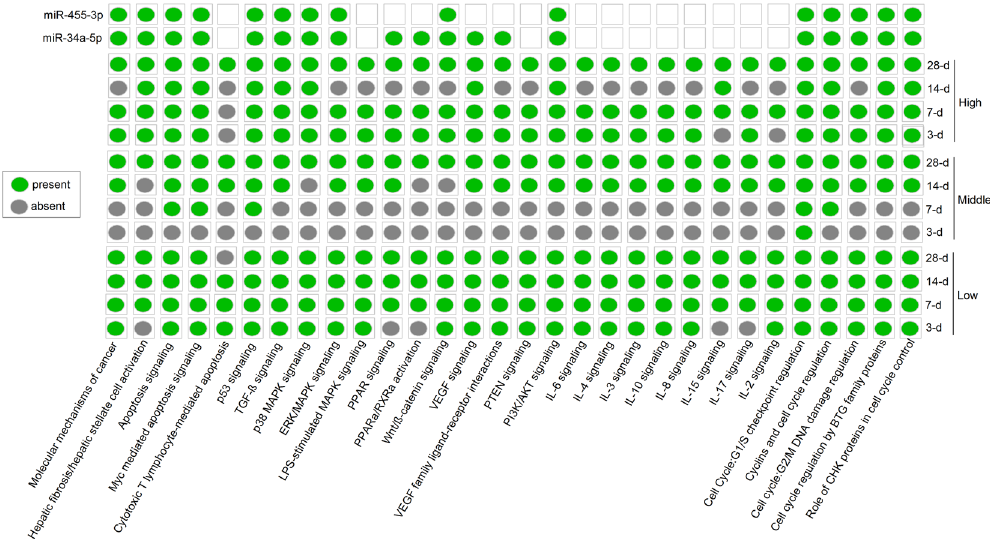
Figure 3. Heat map of most relevant pathways on DEMs. This heat map depicts the most significant and highly relevant pathways obtained using experimentally verified targets of differentially regulated miRNAs (DEMs). Information on different doses and time intervals is shown on the right side and relevant signaling are shown at the bottom. Information on two potential early and sensitive miRNA biomarkers (miR-34a-5p and miR-455-3p) and their associated signaling is given on the top two rows. The top two rows depict whether a given miRNA is predicted to regulate a selected pathway or not. The “green” and “gray” colors indicate either a pathway is present or absent